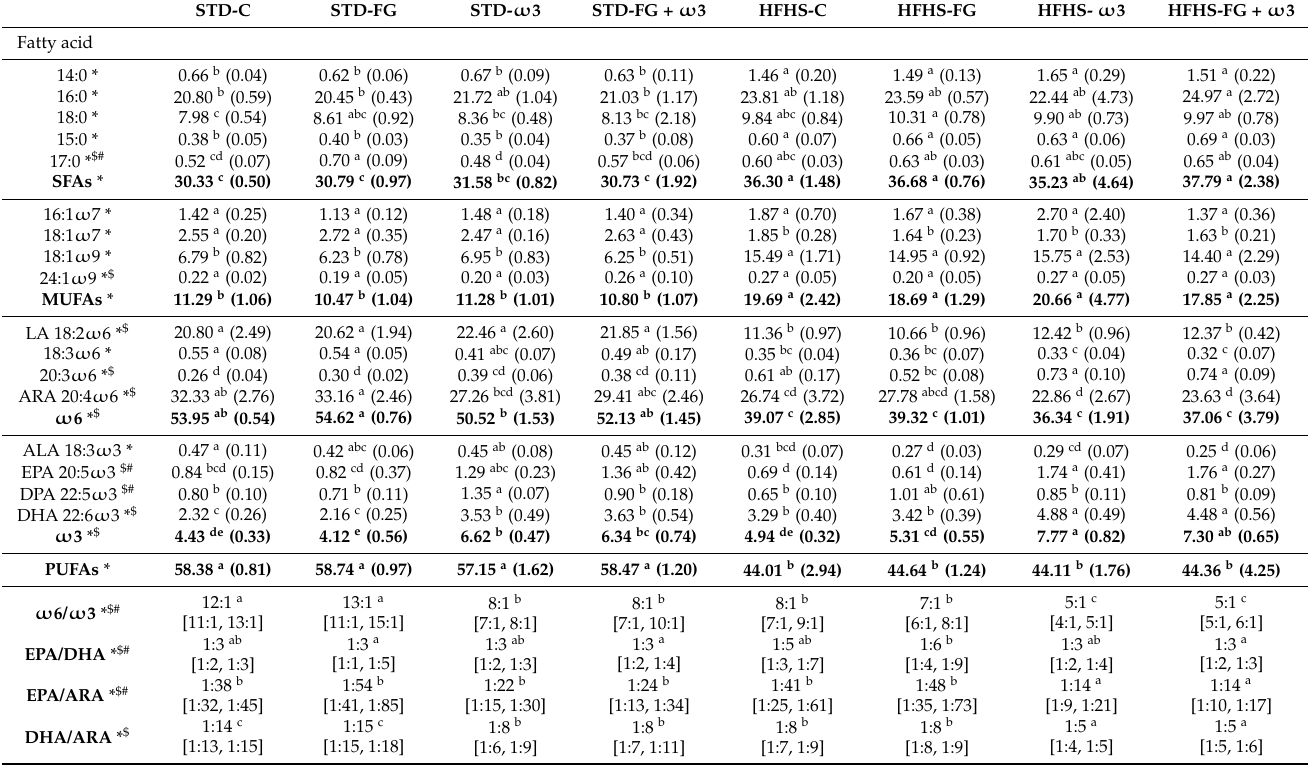
Table 3. Total fatty acids composition of plasma (mg/100 mg of total fatty acids) 1